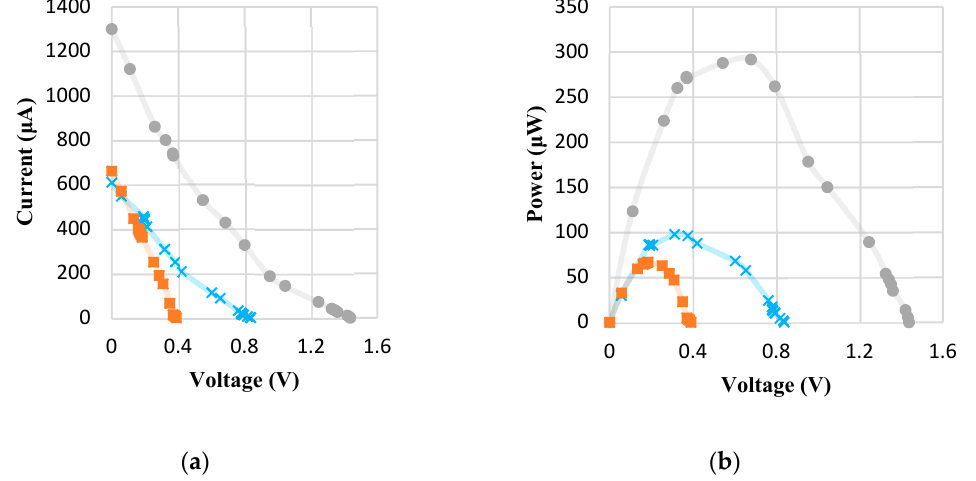
Figure 9. Tests carried out on 7 August 2018: without filters ( — ), with filter OG 515 ( — ), and those with filter OG 550 ( — ) for perovskite organic cell. ( a ) Voltage-current curves and ( b ) voltage-power curves. Both curves were acquired for G = 1000 W / m 2. Table 5. Values of open circuit voltage, maximum power, and respective variations for different tests with and without HP filters for perovskite organic cell for an irradiance of 1000 W / m 2 .